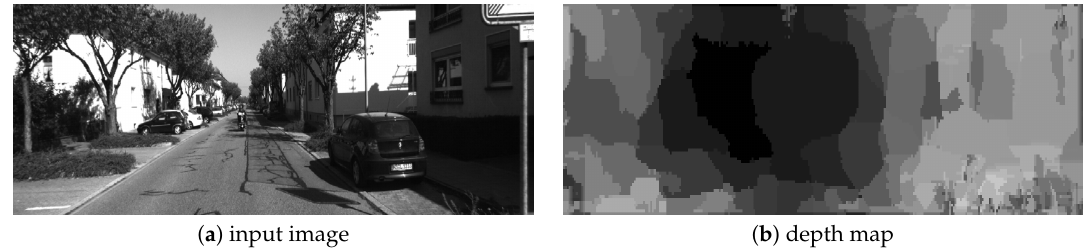
Figure 7. Depth estimation using the proposed algorithm.